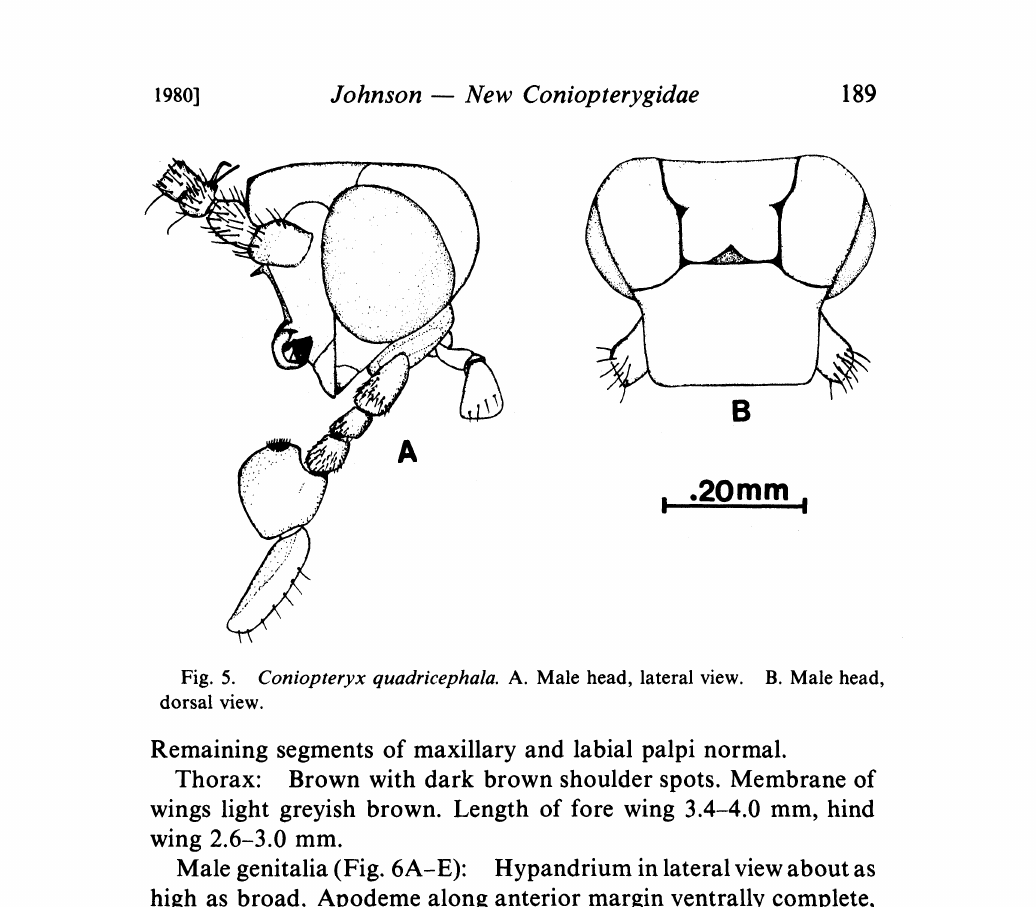
Fig. 5. Coniopteryx quadricephala. A. Male head, lateral view. B. Male head, dorsal view. Remaining segments of maxillary and labial palpi